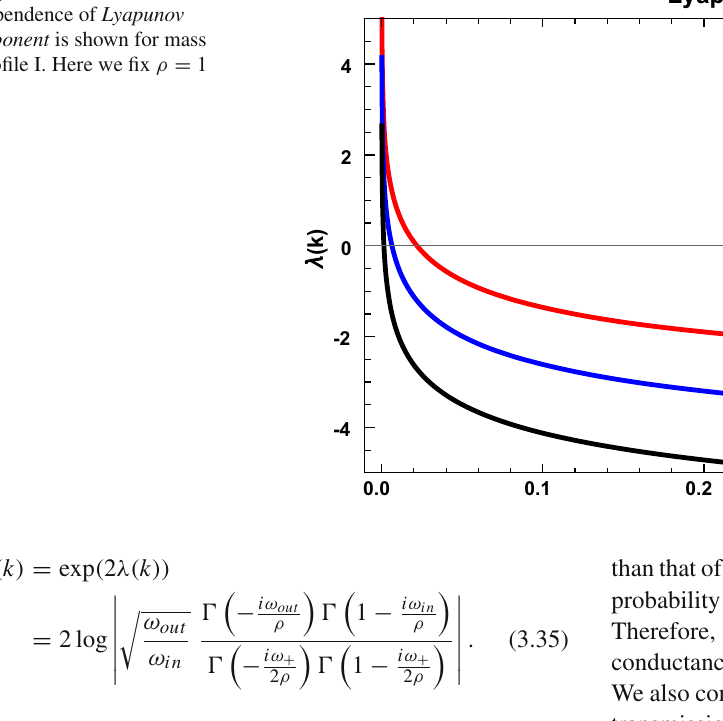
Fig. 7 Wave number dependence of transmission and reflection coefficients for the mass profile I is shown here. Here we fix ρ = 1 Fig. 8 Wave number dependence of Lyapunov exponent is shown for mass profile I. Here we fix ρ =